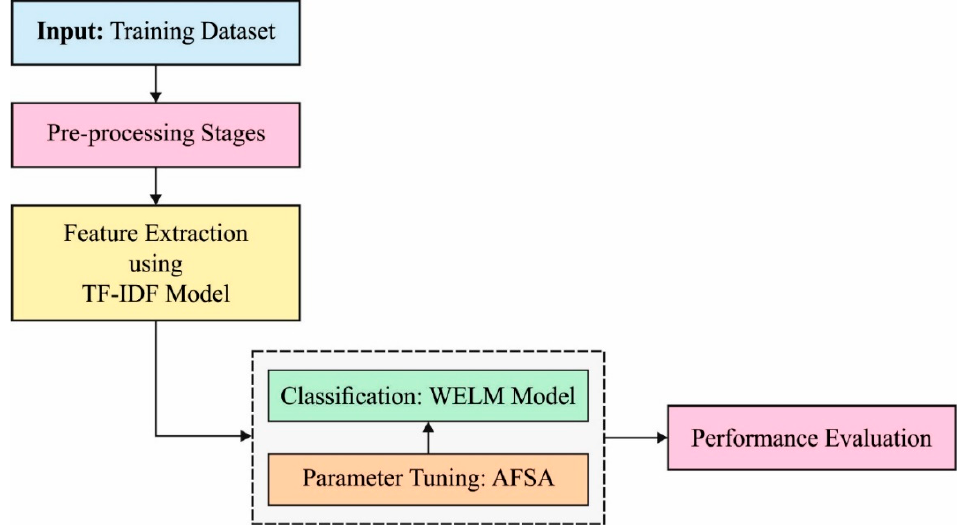
Figure 1. Overall process of the proposed model for secure social media